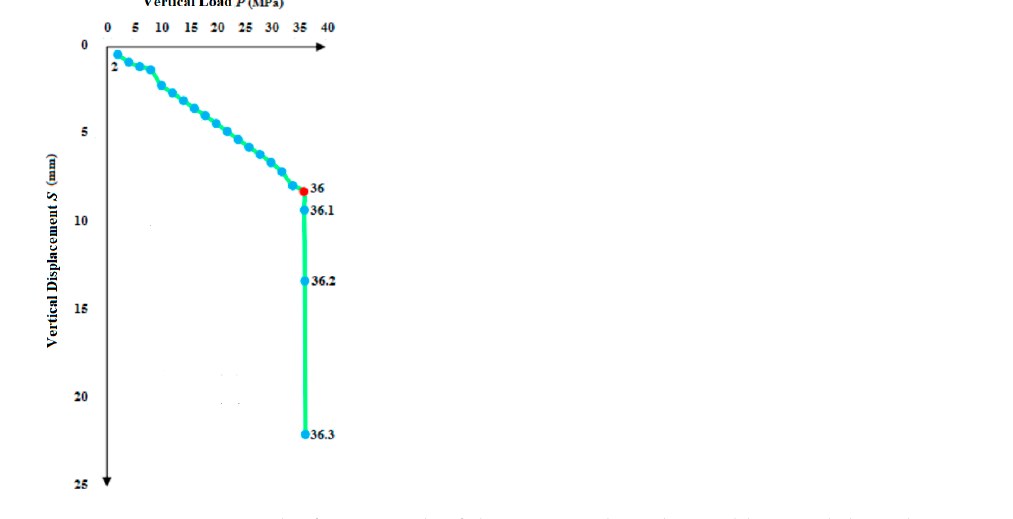
Figure 10. P-S curve is the fitting result of the numerical result in Table 2, and the red point is a sudden shift of vertical subsidence. Table 2. Applied load and corresponding subside of the critical